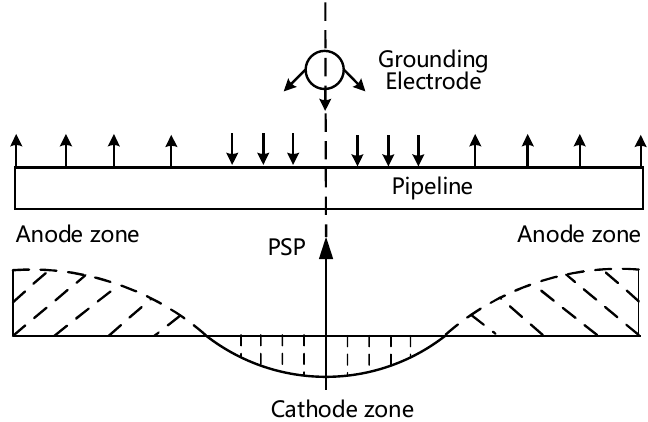
Figure 1. Interference process of HVDC electrode currents on pipelines. Different electrochemical reactions occur for different interference areas [18]. The elec- trochemical reaction for the anode interference area is usually described by: 2F e → 2F e2 + +